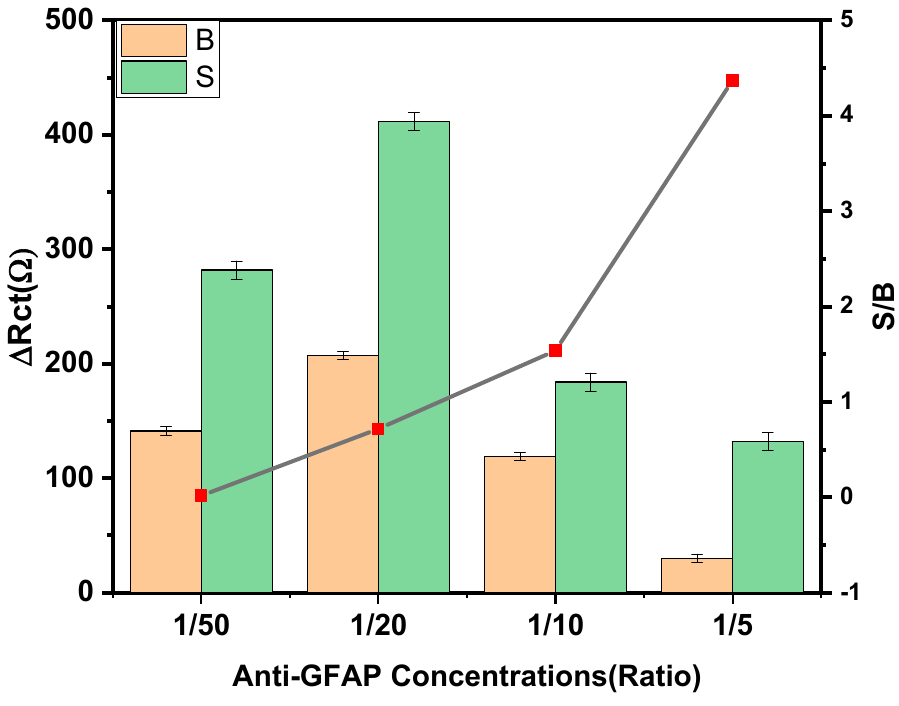
Figure 3. Effect of anti-GFAP loading with the antibody solution on R ct responses measured with the Anti-GFAP/L-cys/AuNPs/SPCE for 0 (B) and 100 (S) pg mL − 1 GFAP standard solutions.